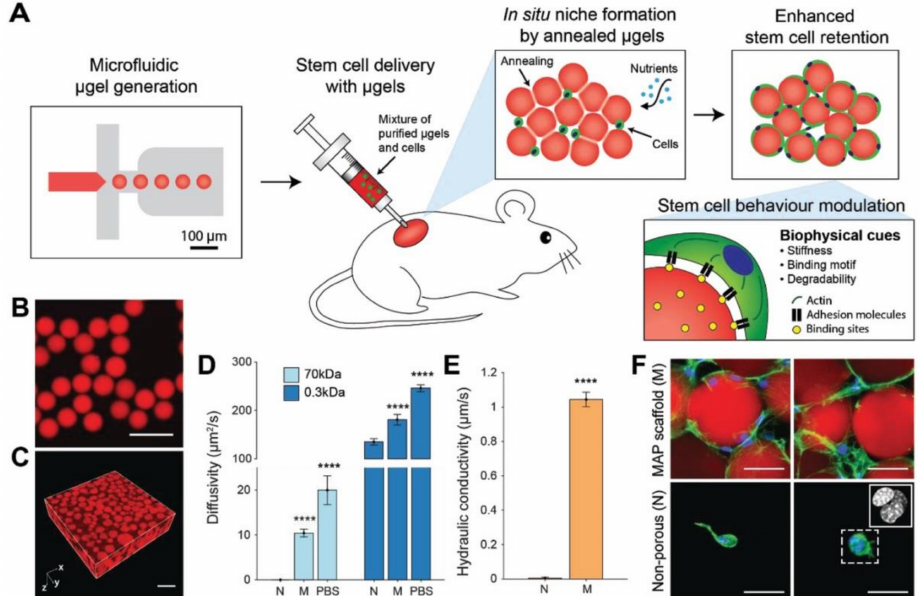
Figure 8. ( A ) Schematics showing how monodisperse hydrogel microparticles (HMPs) are generated and allow for the controlled creation of a pore network within microporous annealed particle (MAP) hydrogels, ultimately promoting cell movement and the transport of oxygen and nutrients. The function of the transplanted stem cells is enhanced by the presence of the hydrogel. ( B , C ) Micrographs of the fluorescent HMPs. ( D , E ) Materials characterization. ( F ) Micrographs of cells on the hydrogel scaffolds. Reproduced with permission from [11]. © 2021 Wiley-VCH Verlag GmbH & Co.